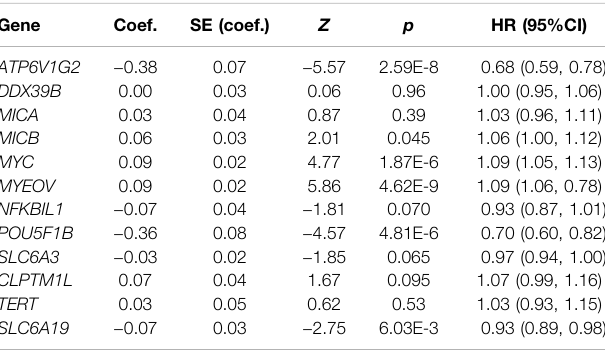
TABLE 3 | Summary of the univariable Cox regression analysis conducted on 12 CAPER genes in the TCGA training set *. Gene